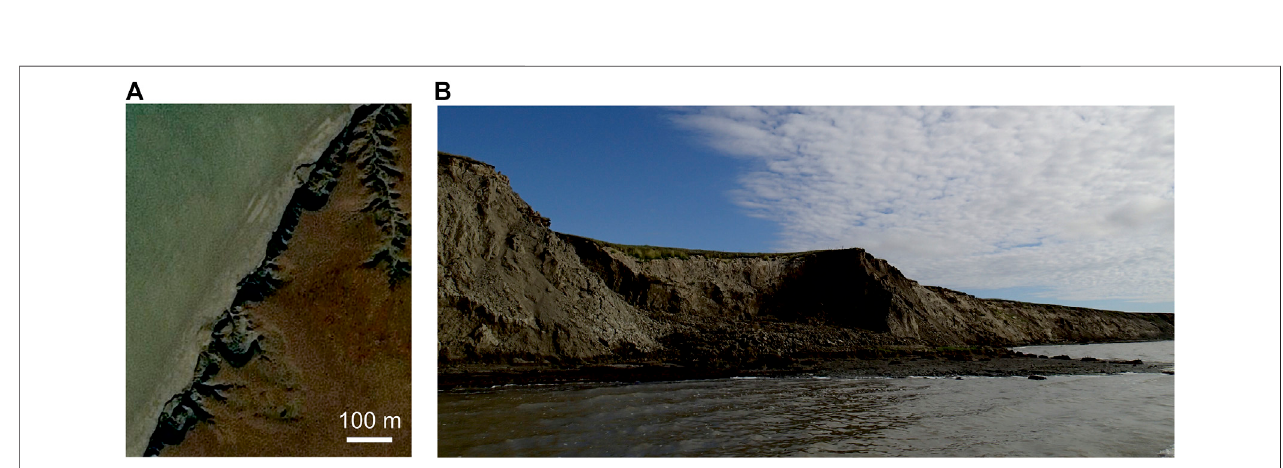
FIGURE 4 | Thermocirque to the north of Cape Yasalya: (A) View from space in 2018 (Yandex Digital Maps, 2020 https://yandex.ru/maps/-/CCVtMVJd). (B) Field view in 2016; the cliff height is ∼ 15 m.